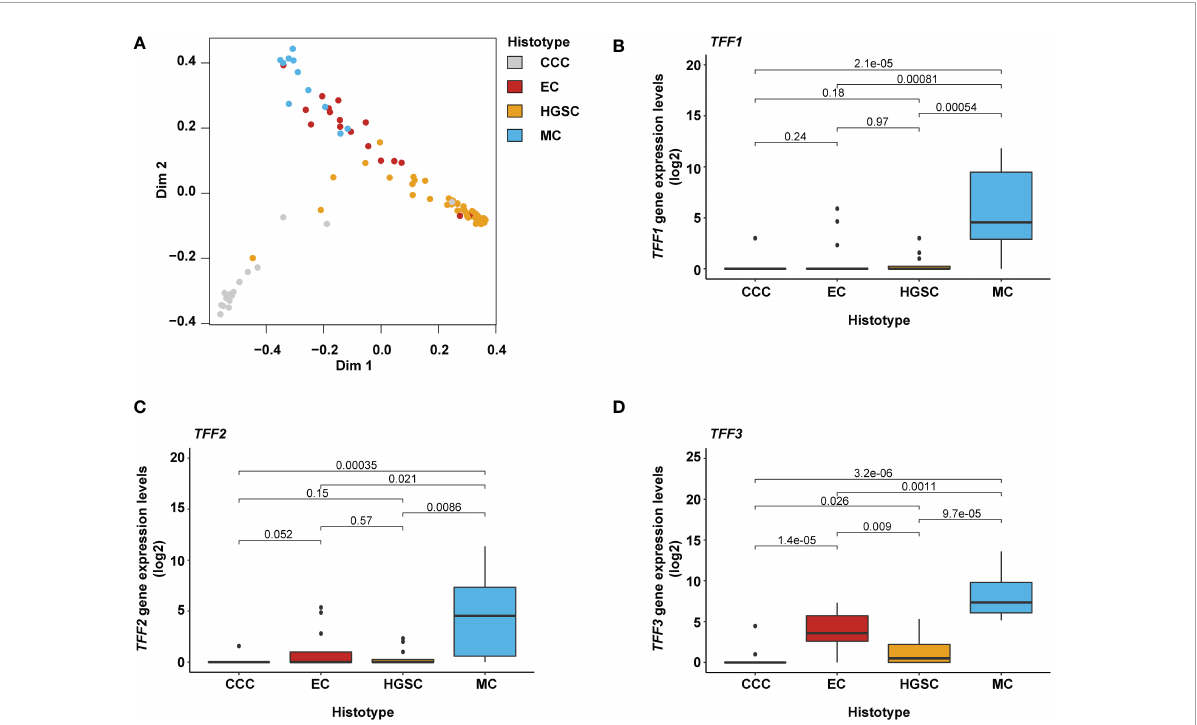
FIGURE 1 Gene-speci fi c expression in mucinous ovarian cancer cell component. (A) MDS (multidimensional scaling) plot illustrating the speci fi city of the 393 identi fi ed genes classifying the different ovarian carcinoma histotypes. (B – D) Box plots showing the distribution of TFF1 , TFF2 , and TFF3 gene expression levels in relation to the different histotypes with the Kruskal-Wallis test and Benjamini-Hochberg adjusted p-values. Expression levels were found to be elevated in MC ovarian carcinomas and small populations in the EC and HGSC histotypes; in EC samples showing mucinous differentiation (an attribute also seen in the HGSC histotype). TFF1 and TFF3 gene expression levels were shown to be signi fi cantly elevated for MC compared to other histotypes. CCC, Clear cell carcinoma; EC, Endometroid carcinoma; HGSC, High-grade serous carcinoma; and MC, mucinous